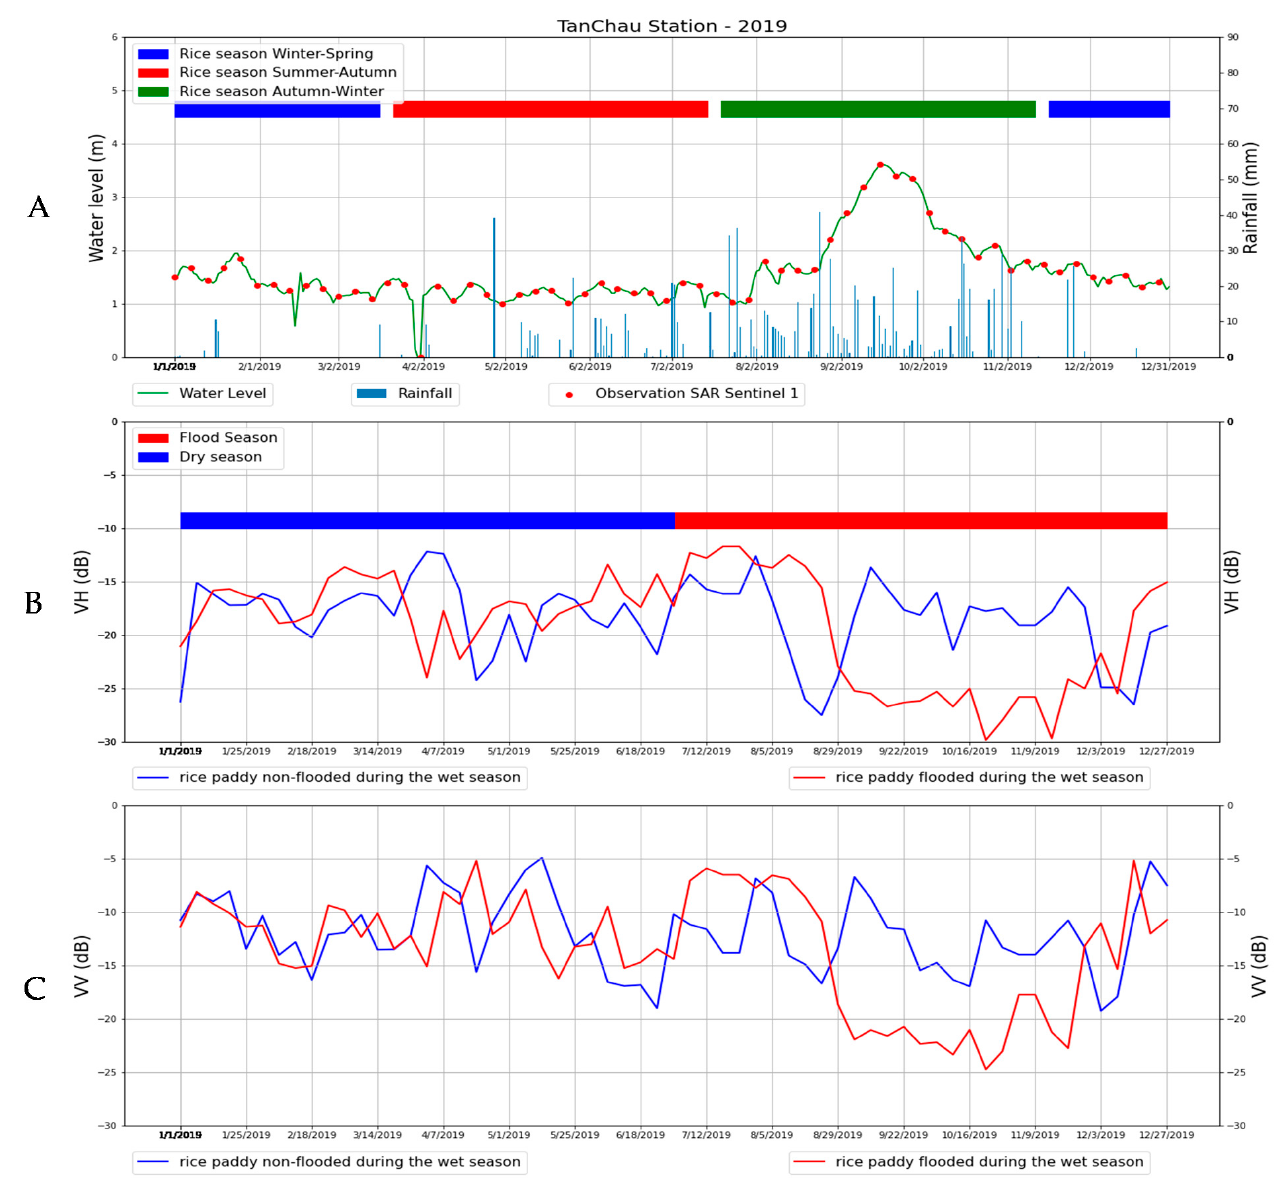
Figure 8. ( A ) Daily rainfall and daily water levels of the Mekong River recorded at the Tan Chau hydro-meteorological station during 2019. Seasons of the three rice cycles (rice seasons winter-spring, summer-autumn and autumn-winter). SAR Sentinel-1 observations: 60 images for 2019; ( B ) temporal VH profiles of non-flooded rice paddies during the wet season and of flooded rice paddies during the wet season; ( C ) temporal VV profiles of non-flooded rice paddies during the wet season and of flooded rice paddies during the wet season.